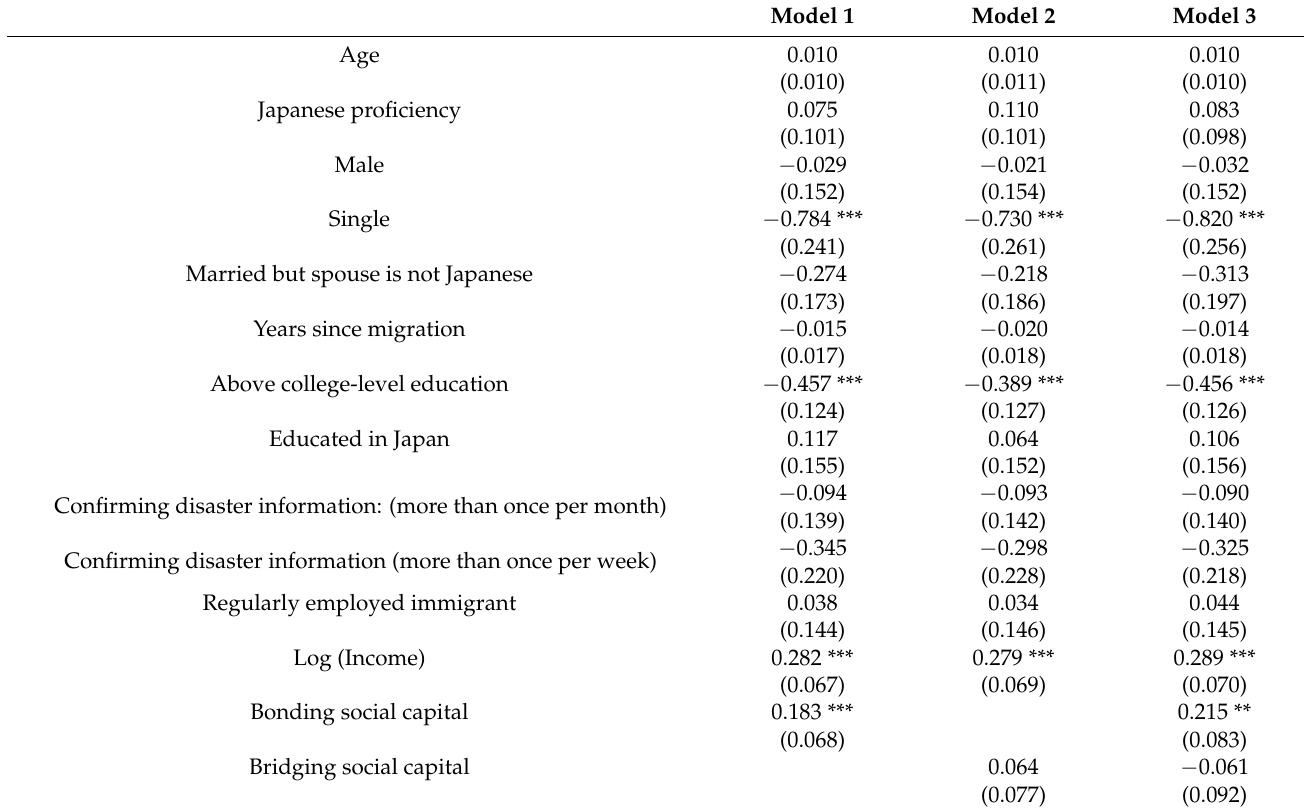
Table 7. Regression analysis of immigrants’ psychological